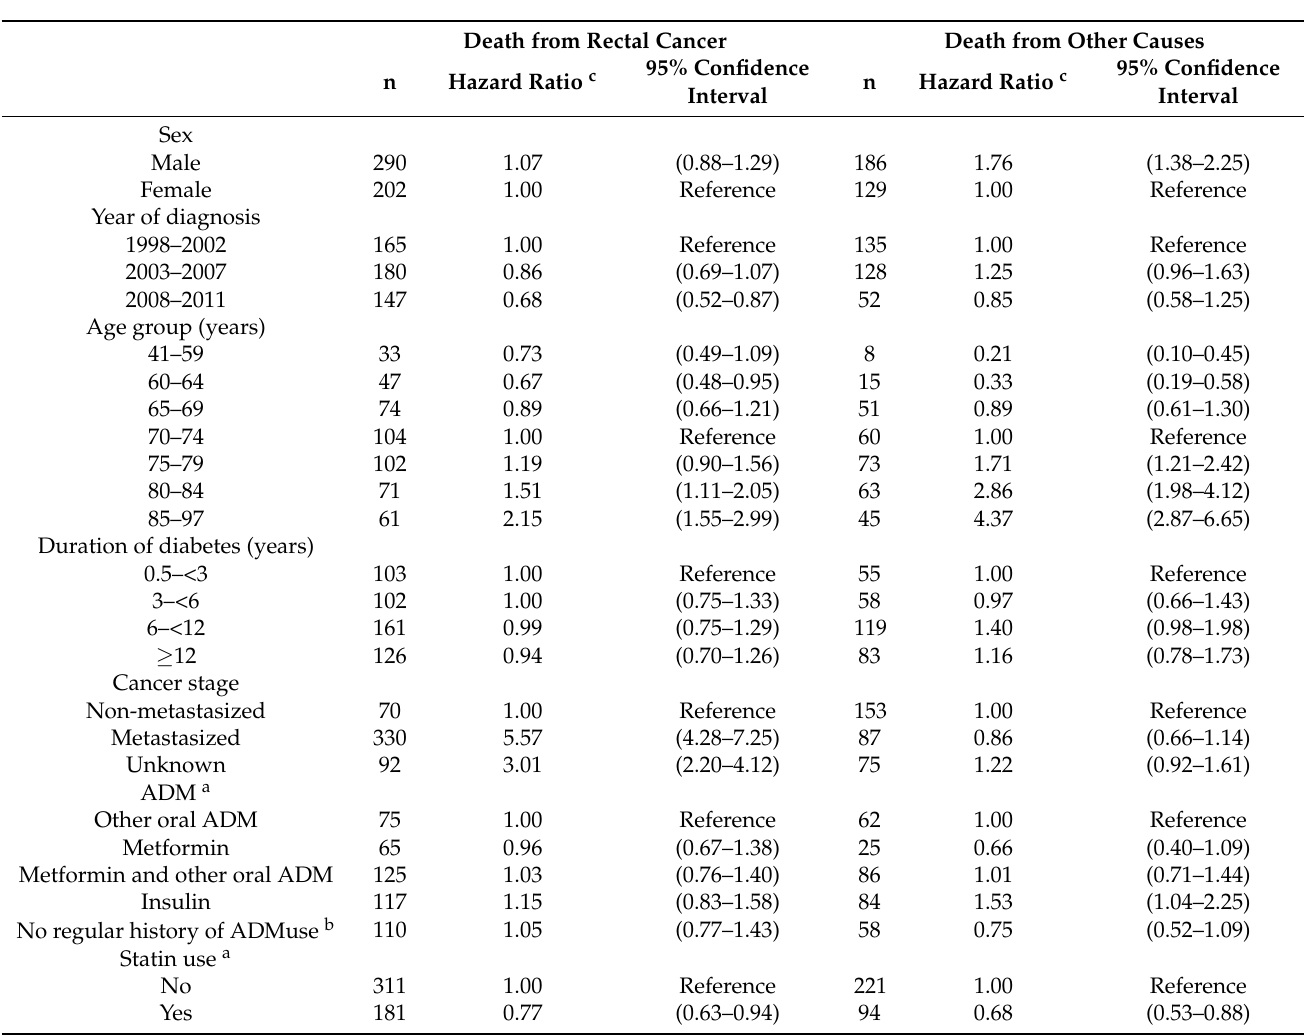
Table 2. Numbers of deaths (n) by cause and estimated hazard ratios (HR) with 95% confidence intervals (CI) related to mortality from rectal cancer (RC) and from other causes by sex, year of diagnosis, age, stage, antidiabetic medication (ADM), and the use of statins during the three years before the diagnosis of RC. The estimation results are based on Cox regression models, including all